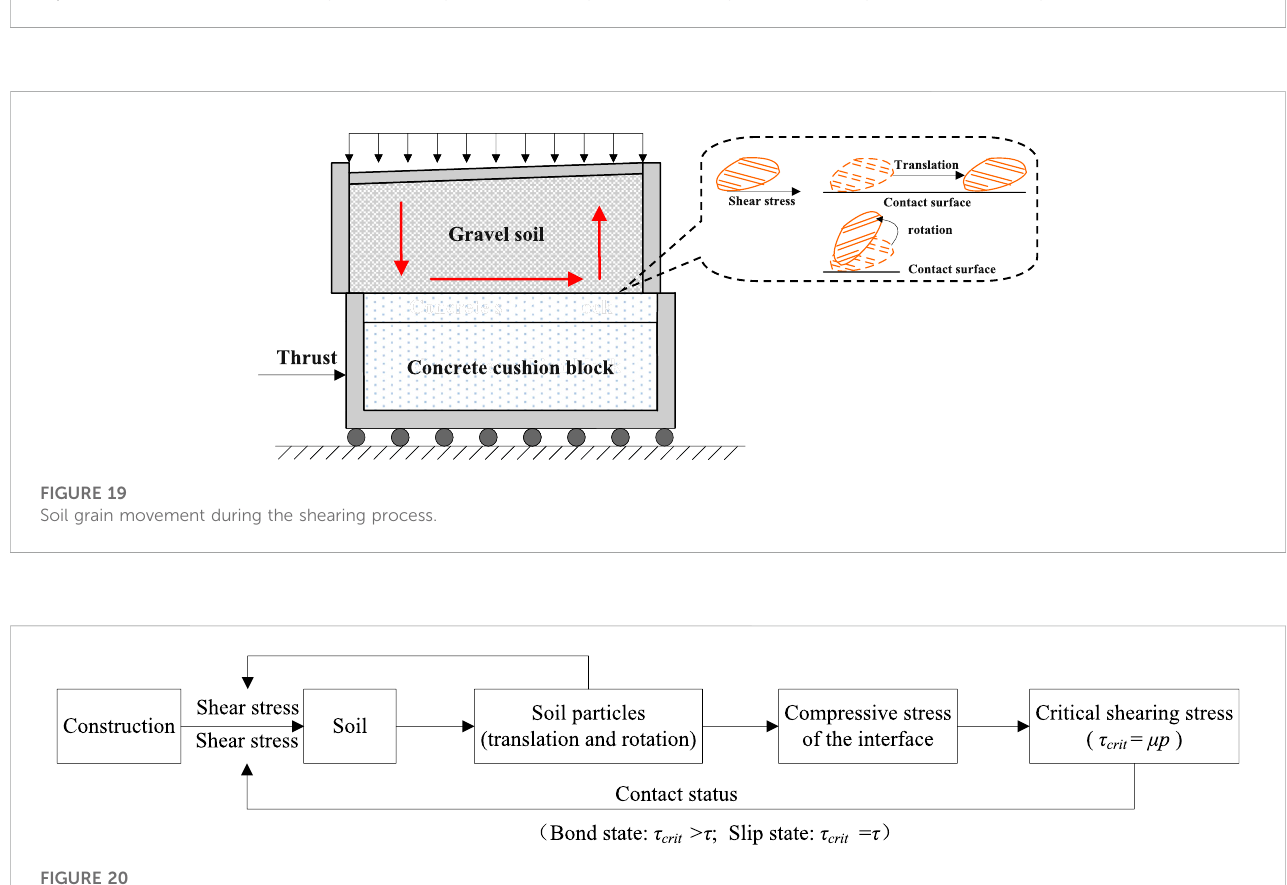
FIGURE 18 The distribution of shear stress along the horizontal path with different shear displacements ( σ n =100 kPa) (Black represents critical shear stress; Red represents actual shear stress) (A) w s =0 mm, (B) w s =0.08 mm, (C) w s =0.61 mm, (D) w s =35.5 mm, (E) w s =48.9 mm, and (F) w s =80 mm.